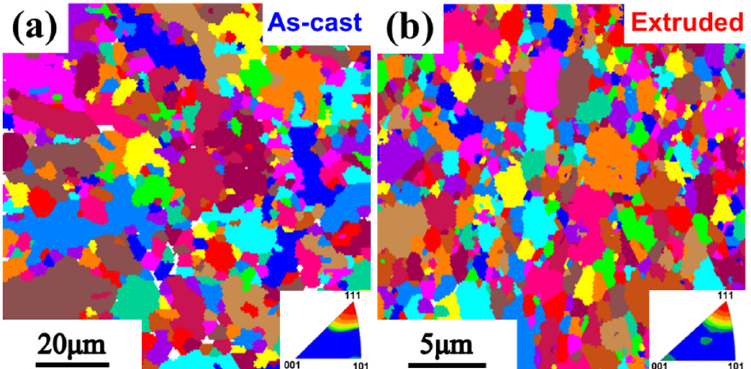
Figure 9. EBSD images of nano ‐ AlN/AA6061 composite: ( a ) As ‐ cast; ( b ) After